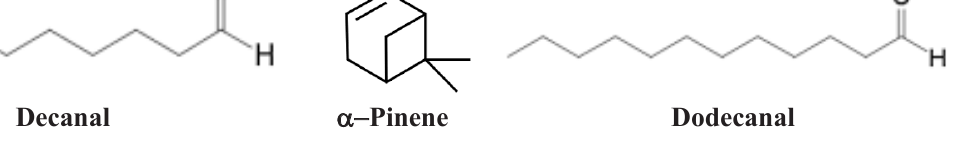
Figure 1: Major constituents of DIEO.